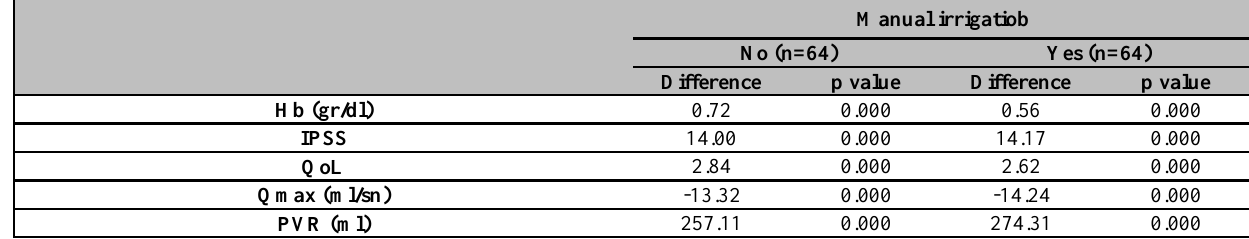
Table 3: Pre-operative and post-operative differences of patient